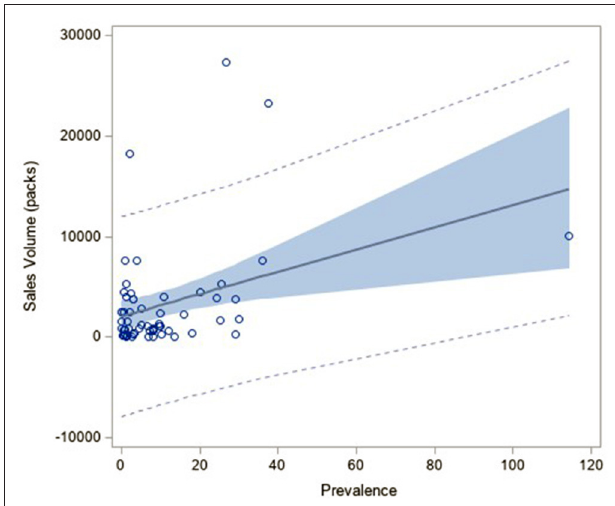
FIGURE 4 | Correlation analysis between the sales volume in the first year of commercialization in Italy and the prevalence of the related rare diseases.